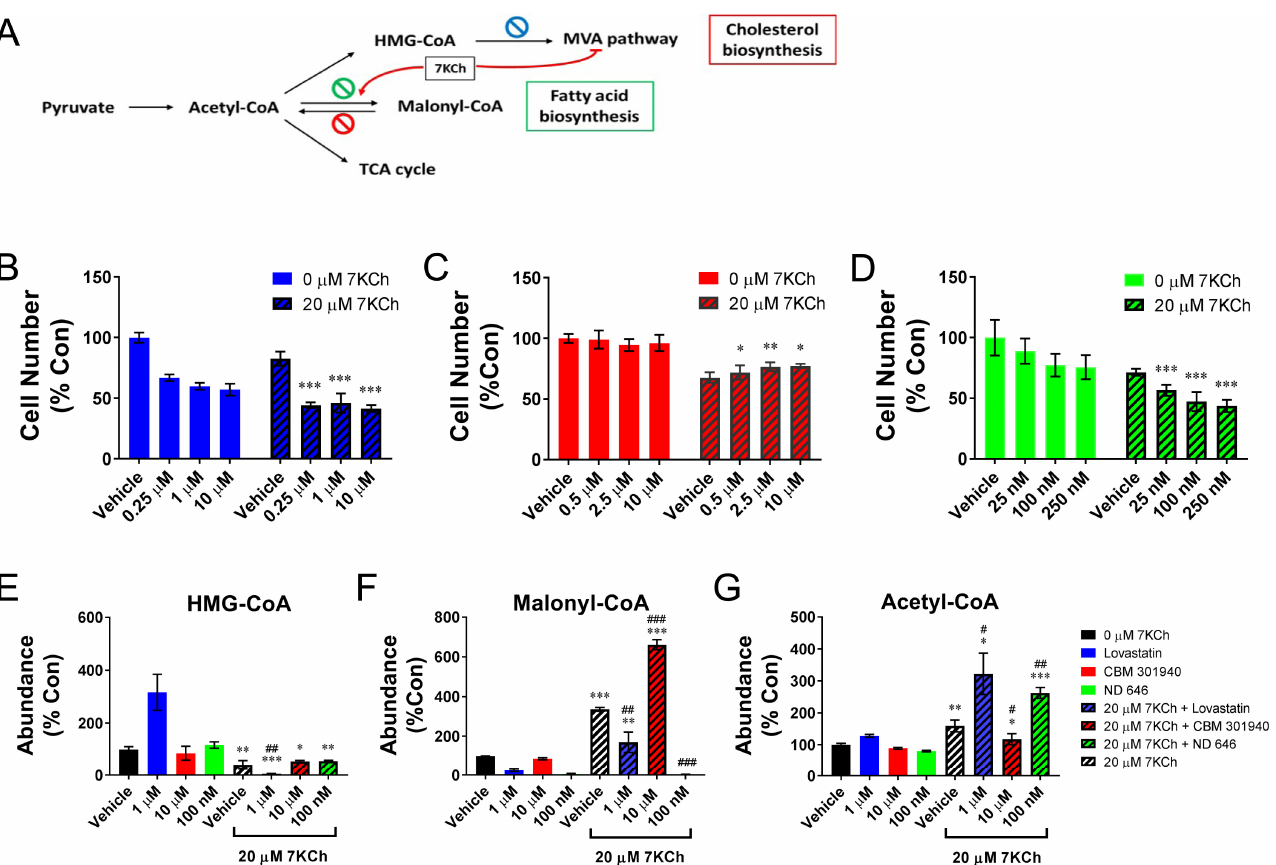
Figure 6. Accumulation of malonyl-CoA partially reverses the growth inhibitory effect of 7KCh. ( A ) A schematic diagram shows the enzymatic reactions at which pharmacological inhibitors act. CBM 301940 is an inhibitor of malonyl-CoA decarboxylase (red stop sign); ND 646 is an inhibitor of acetyl-CoA carboxylase (green stop sign); lovastatin is an inhibitor of HMGCR (blue stop sign). ( B – D ) The HL-1 cells were seeded at a cell density of 5 × 10 4 per well of a 24-well culture plate, and after attachment, they were treated with the vehicle (vehicle) or with 0.25, 1, or 10 μ M lovastatin ( B ), with the vehicle (vehicle) or with 0.5, 2.5, or 10 μ M CBM 301940 ( C ), or with the vehicle (vehicle) or with 25, 100 or 250 nM ND 646 ( D ), in addition to 0 μ M (i.e., the DMSO vehicle control; solid bar) or 20 μ M 7KCh (striped bar) for 24 h. The cells were stained with Hoechst 33342, and the cell number was quantified using IN Cell Analyzer 1000. Data are mean ± SD of six experiments. * p < 0.05, ** p < 0.01, *** p < 0.005 vs. the vehicle group for the respective inhibitor treatment. ( E – G ) The cells were similarly treated with 7KCh and the pharmacological inhibitors and extracted for the quantification of HMG-CoA, malonyl-CoA, and acetyl-CoA. The abundances of these metabolites are expressed as the percentage relative to those of the cells that were treated with neither 7KCh nor any pharmacological inhibitor. Data are mean ± SD, N = 3. * p < 0.05, ** p < 0.01, *** p < 0.005, the 7KCh treatment group vs. the non-treatment group; # p < 0.05, ## p < 0.01, ### p < 0.005 vs. the vehicle group for the respective inhibitor treatment.